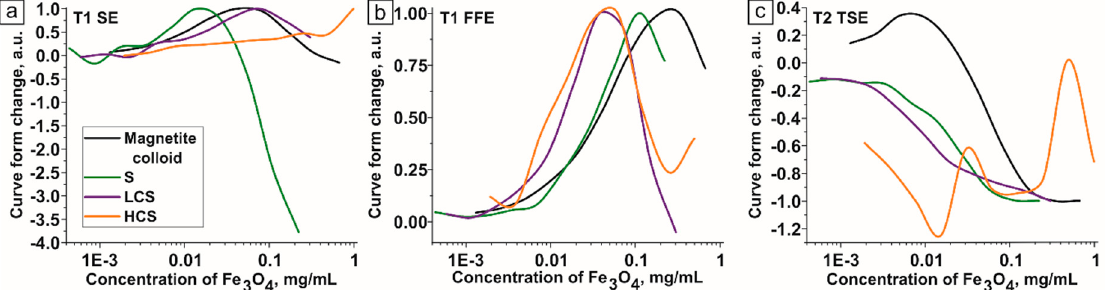
Figure 9. Curve form changes for magnetite colloid and core–shell suspensions in ( a ) T1 SE, ( b ) T1 FFE, and ( c ) T2 TSE modes.